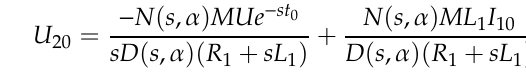
Figure 12. Current curve at the input of the two ‐ port network for the whole time interval.